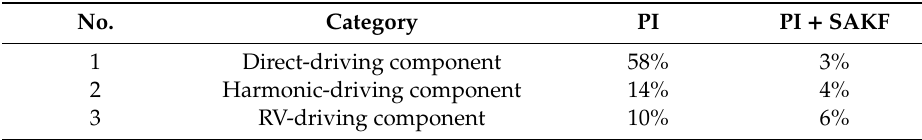
Table 4. Comparison of stabilization